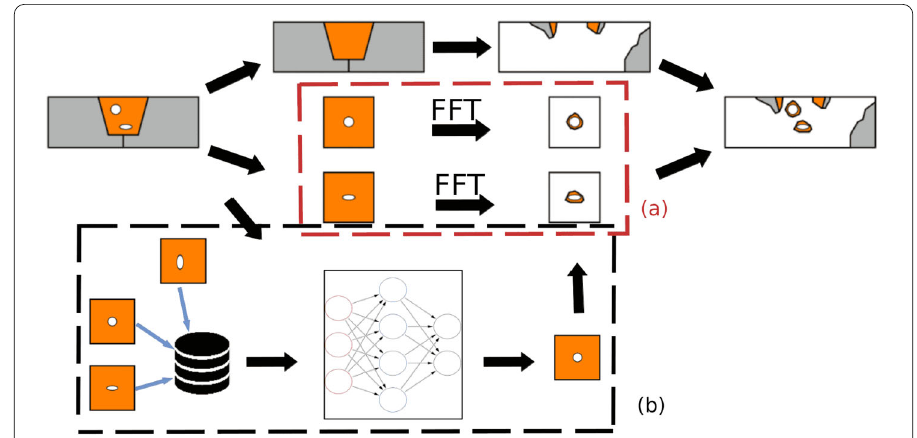
Figure 2 Schematic view of the hyper-reduction method. The structure and defects are treated separately. Orange: fusion zone; grey: base metal. Areas in white are not meshed. In the classical method [2], numerical computations are performed for each new defect (rectangle a ). In the proposed approach, the pre-computed mechanical response of a nearest defect is used (rectangle b